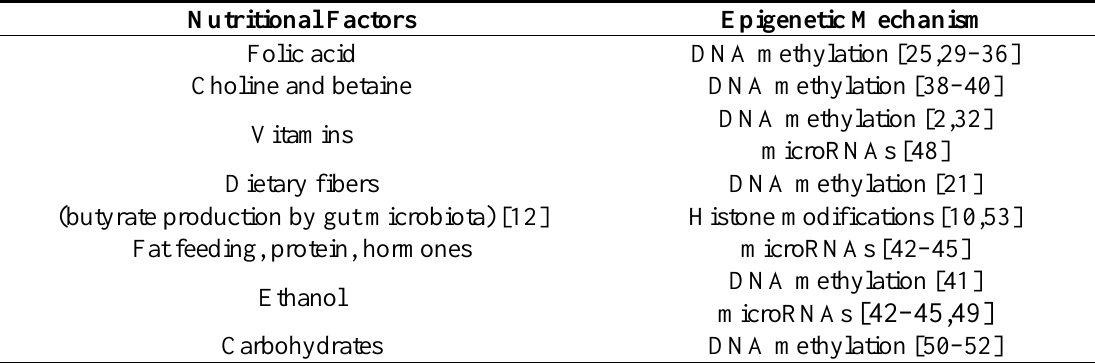
Table 1. Main nutritional factors influencing the immune system through an epigenetic